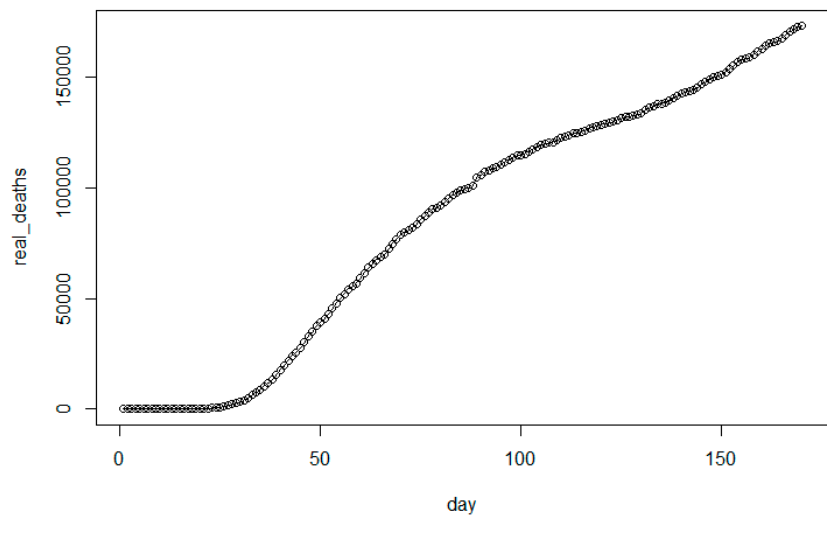
Figure 1. Cumulative number of deaths over time for the United States.